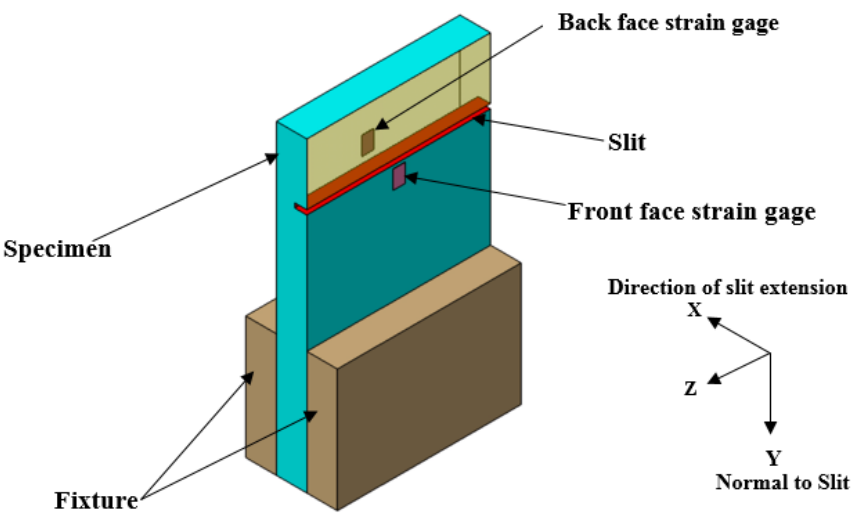
Figure 2. Details of Slitting Specimen.